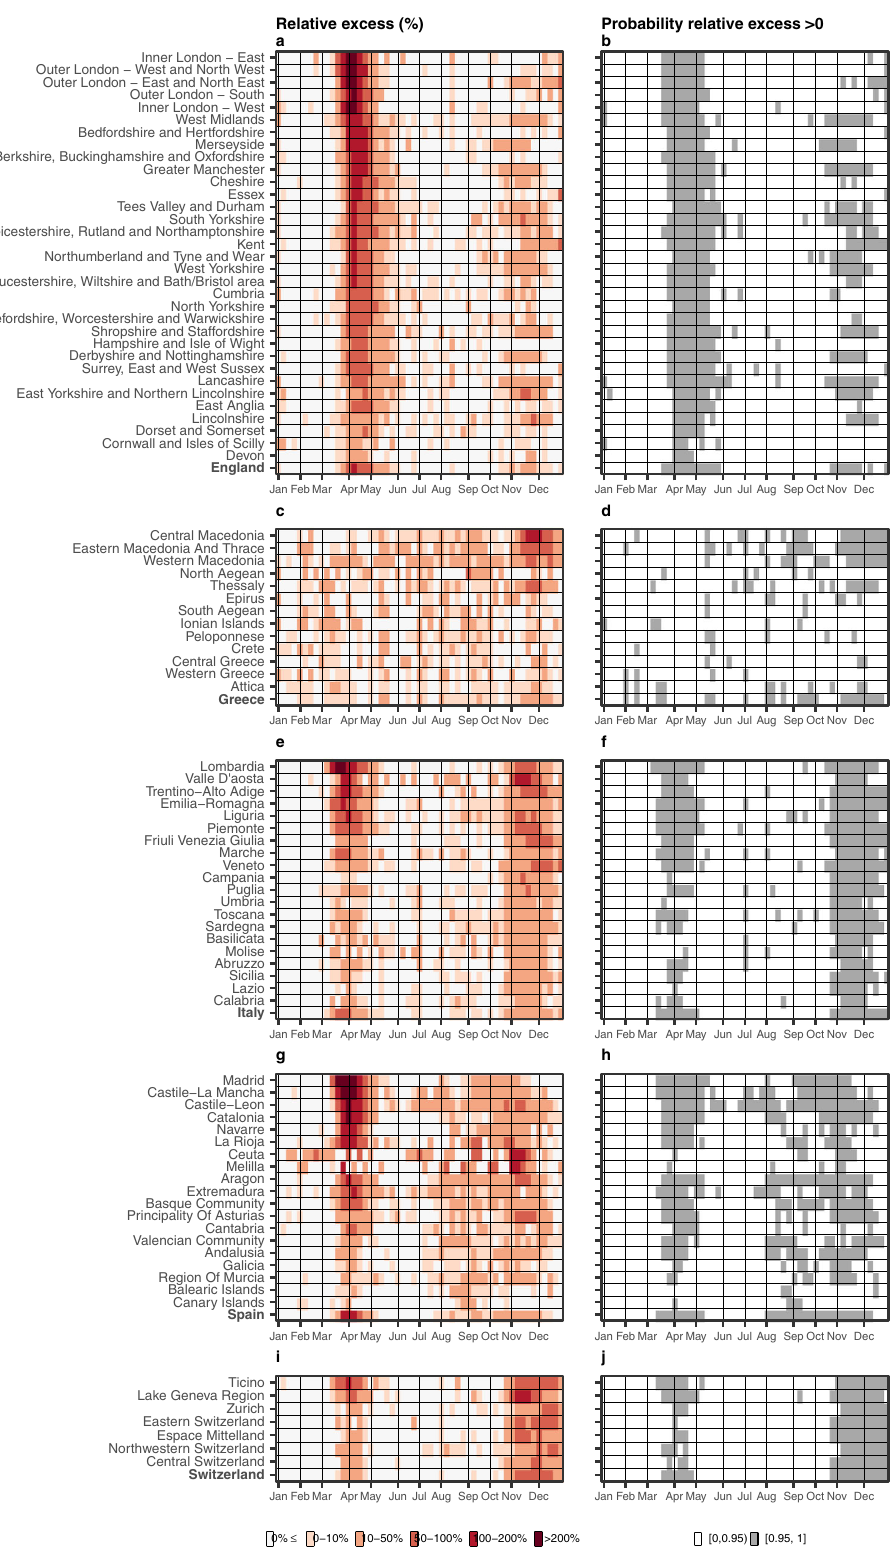
probably been the most important factors 31,32 . We observed weak, but consistent, evidence of differences in the excess mor- tality by sex in England, with potential explanations being risk factors that are known to change with sex including differences in occupation, lifestyle, medical comorbidities, or use of medications 33